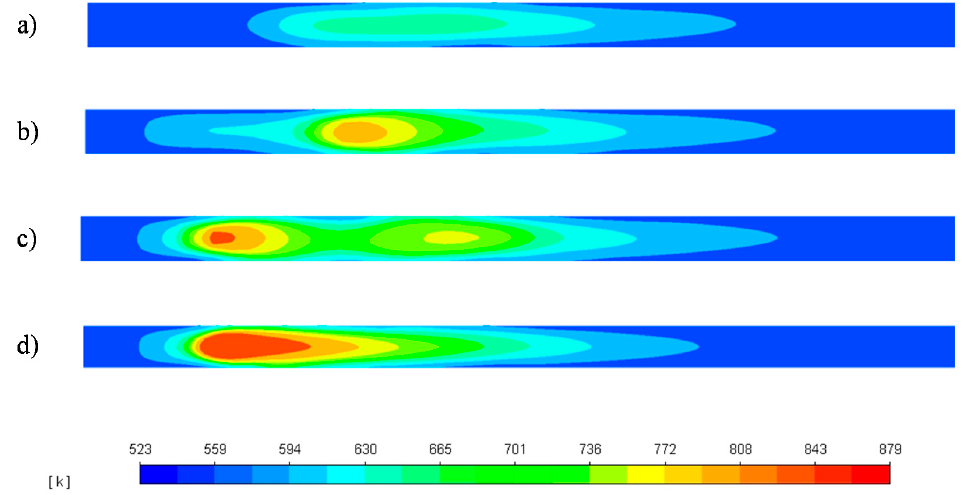
Figure 6. Temperature contours in the hot-spot relevant zone after a 30 s H 2 feed disruption at t: ( a )